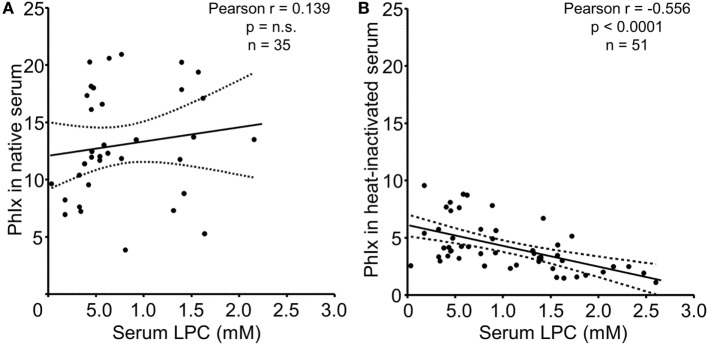
Serum lysophosphatidylcholine (LPC) levels of systemic lupus erythematosus (SLE) patients correlate negatively with phagocytosis of necrotic cells in vitro. Serum LPC levels of SLE patients were correlated to phagocytosis of necrotic cells in the presence of the respective serum as determined by the phagocytosis index (PhIx). Each data point represents an individual serum value. (A) Phagocytosis assays in the presence of native serum. n.s., not significant. (B) Phagocytosis assays in the presence of heat-inactivated serum. Dashed lines indicate the 95% confidence interval.